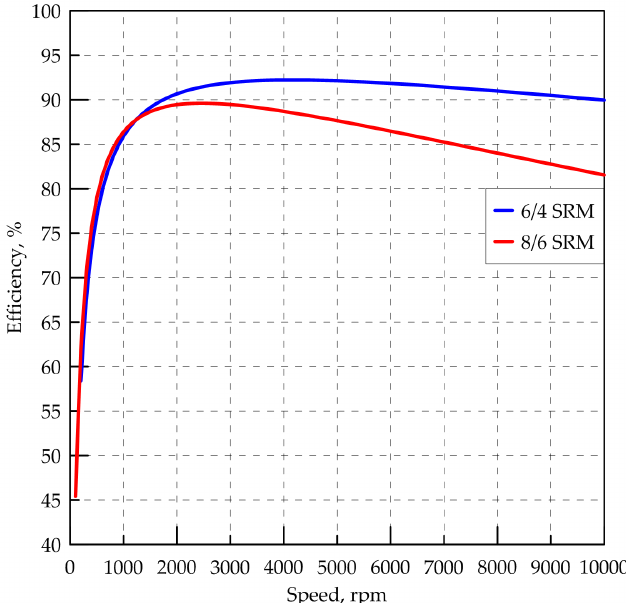
Figure 10. Efficiency of selected optimal designs A1 (8/6 SRM) and B1 (6/4 SRM) at different